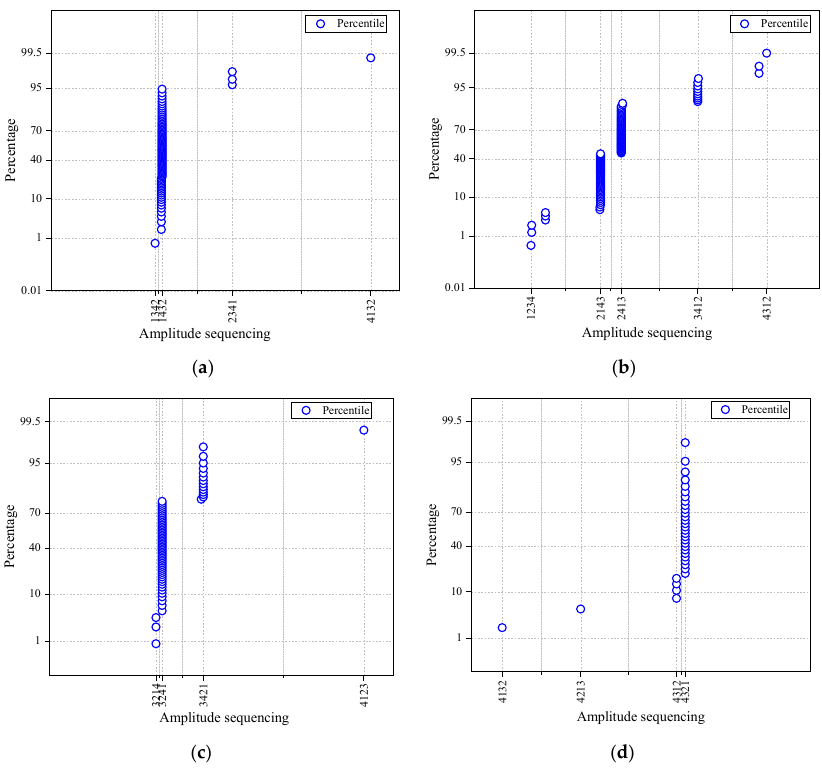
Figure 6. Identical statistical proportion of amplitude sequencing in four periods. ( a ) June 1~June 12; ( b ) June 13~June 23; ( c ) June 23~June 30; ( d ) July 1~July 9.